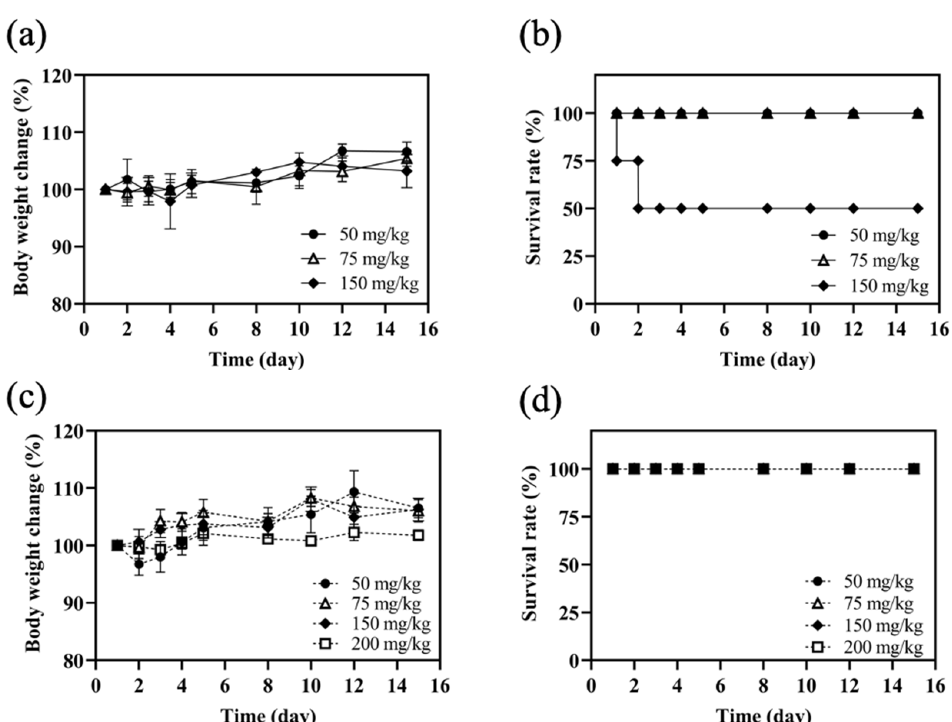
Figure 9. Determination of the maximum tolerated dose (MTD) of MPT0B291 and MPT0B291-human serum albumin (HSA) nanoparticles (NPs) in mice. Body weight changes and survival rates of female BALB/c mice after single-dose intravenous administration with 50, 75 and 150 mg/kg of MPT0B291 solution ( a , b ) and with 50, 75, 150 and 200 mg/kg of MPT0B291-HSA NPs ( c , d ), respectively. Each point represents the mean ± SD. Error bars represent the standard deviation ( n =